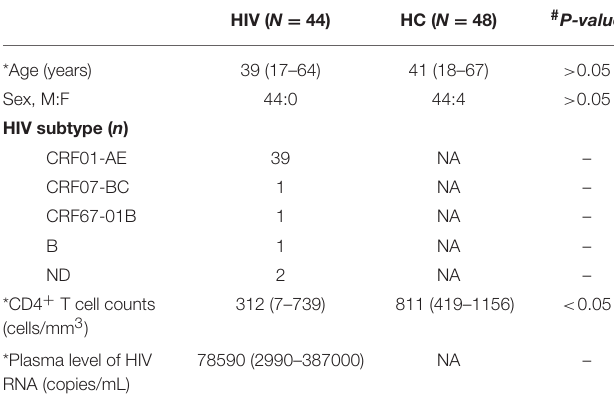
TABLE 1 | Characteristics of study